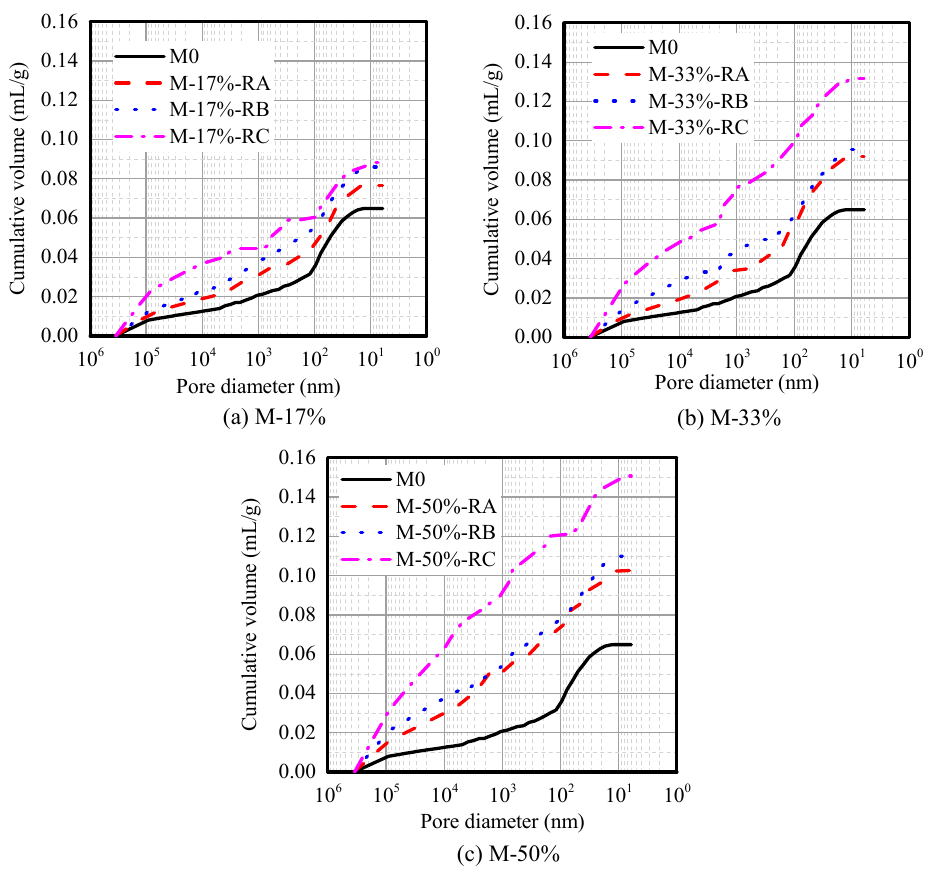
Figure 7. Pore distribution for CRMs.